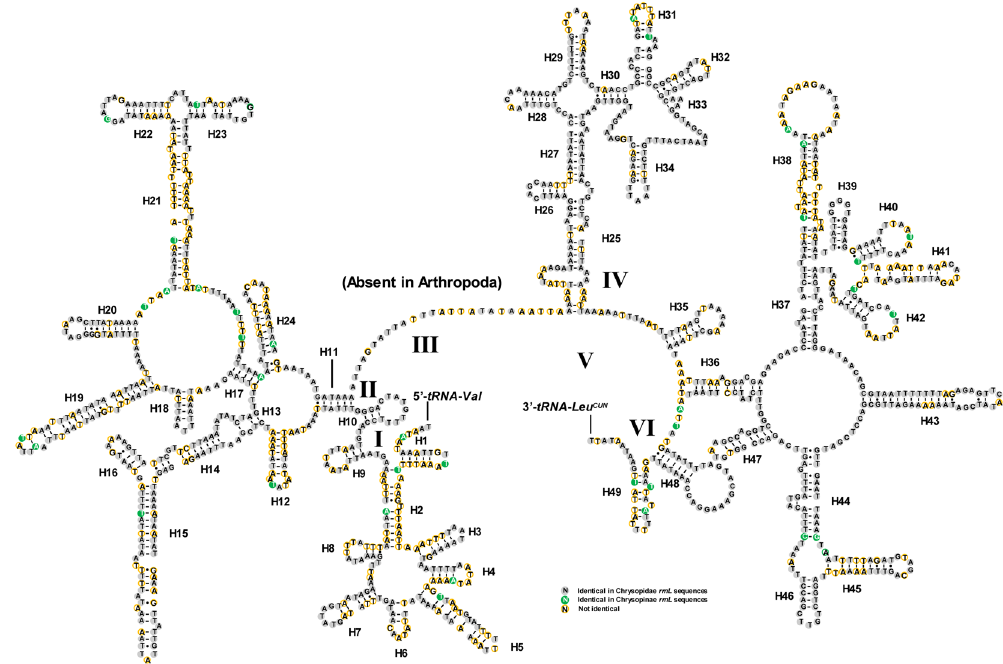
Figure 3. Predicted secondary structure of the rrnL in the Abachrysa eureka mt genomes. Roman numerals denote the conserved domain structure. Dash (-) indicates Watson-Crick base pairing and dot ( • ) indicates G-U base pairing.